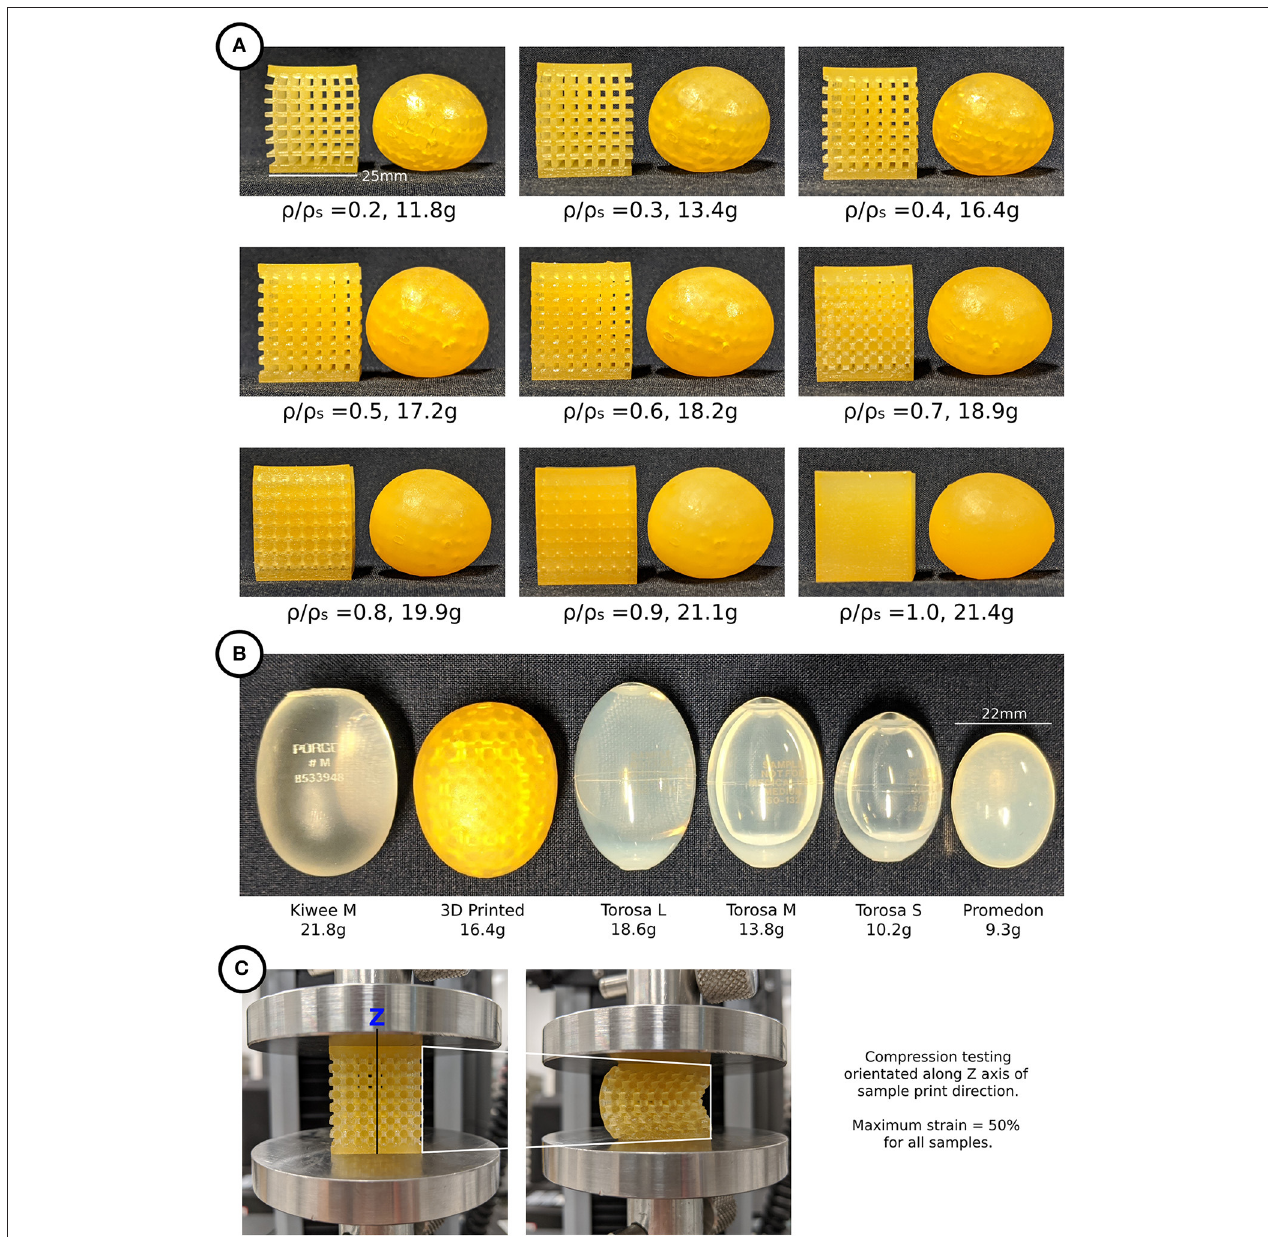
FIGURE 3 | (A) 3D printed testicular prostheses and cubic lattice compression samples of relative density 0.2–1.0, (B) Medical prostheses Kiwee, Torosa, and Promedon (L, large; M, medium; S, small) next to a 3D printed testicular prosthesis, (C) Compression testing of cubic lattice samples showing